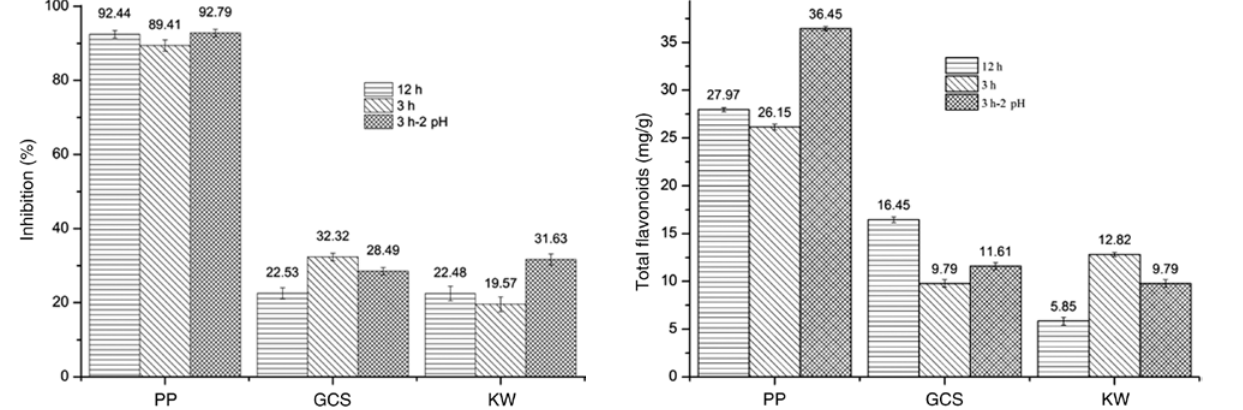
Figure 2: Percentage inhibition or antioxidant activity of extracts at different extraction conditions.